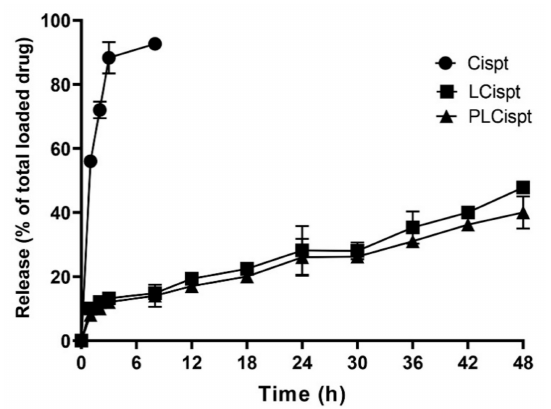
Figure 4. Release pattern of Cispt from Cispt, LCispt, and PLCispt. Statistical analyses were performed using one-way analysis of variance (ANOVA) and F-tests. The data are expressed as mean ± SD ( n = 3).